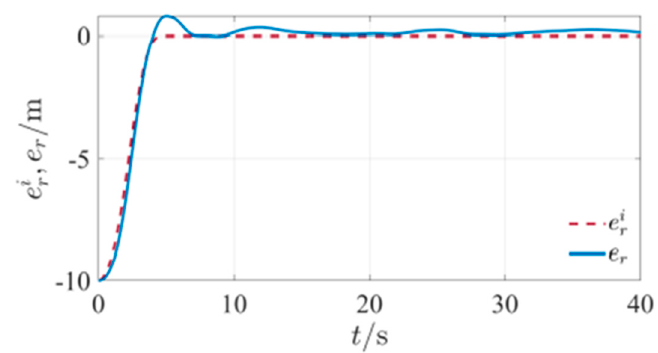
Figure 31. Diagram of radial error.